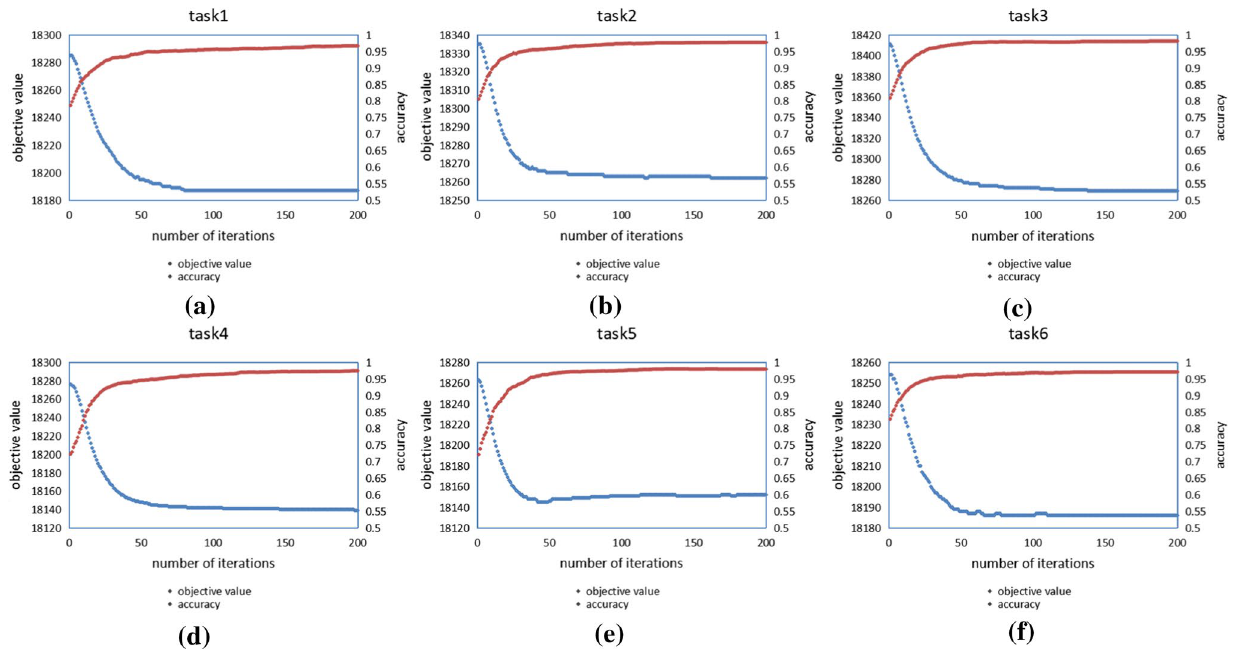
Fig. 4 Verification of convergence of parameter sensitivity of DSTL on five randomly selected